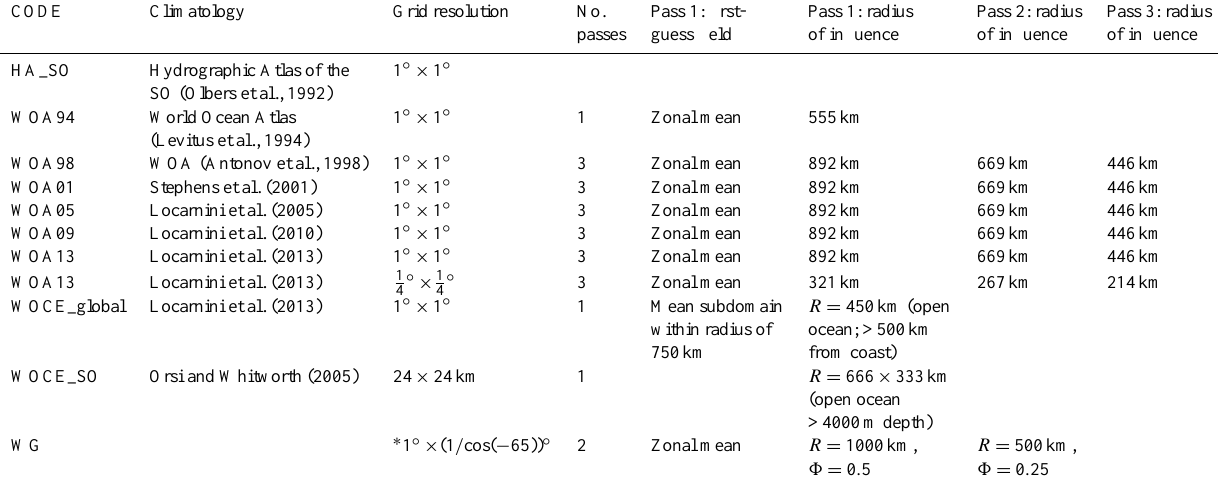
Table 2. List of climatologies discussed in Sect. 6, along with their corresponding grid resolutions, number of interpolation passes, the first-guess fields and radii of influence for each interpolation pass.